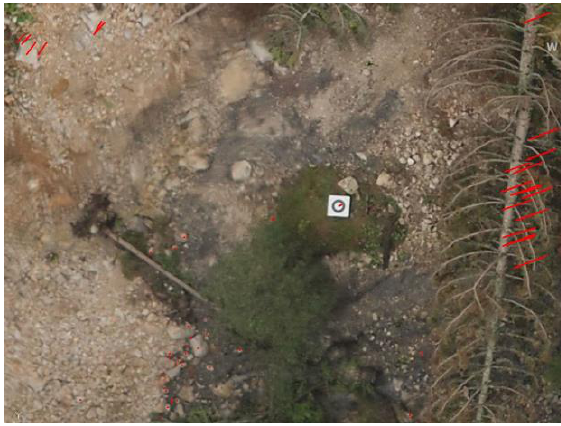
Figure 6. Displacement vectors after filtering Take a look into how well each candidate agrees with its nearest 10 neighbours. For shorter vectors focus on checking how well a candidate vector length agrees with neighbourhood and for longer vectors focus on how well a vector direction agrees with its neighbourhood. If a candidate vector agrees with six or more neighbouring vectors the candidate is accepted as a displacement vector. There are 930 displacement vectors left after filtering – roughly 4.5 displacement vectors per square meter.